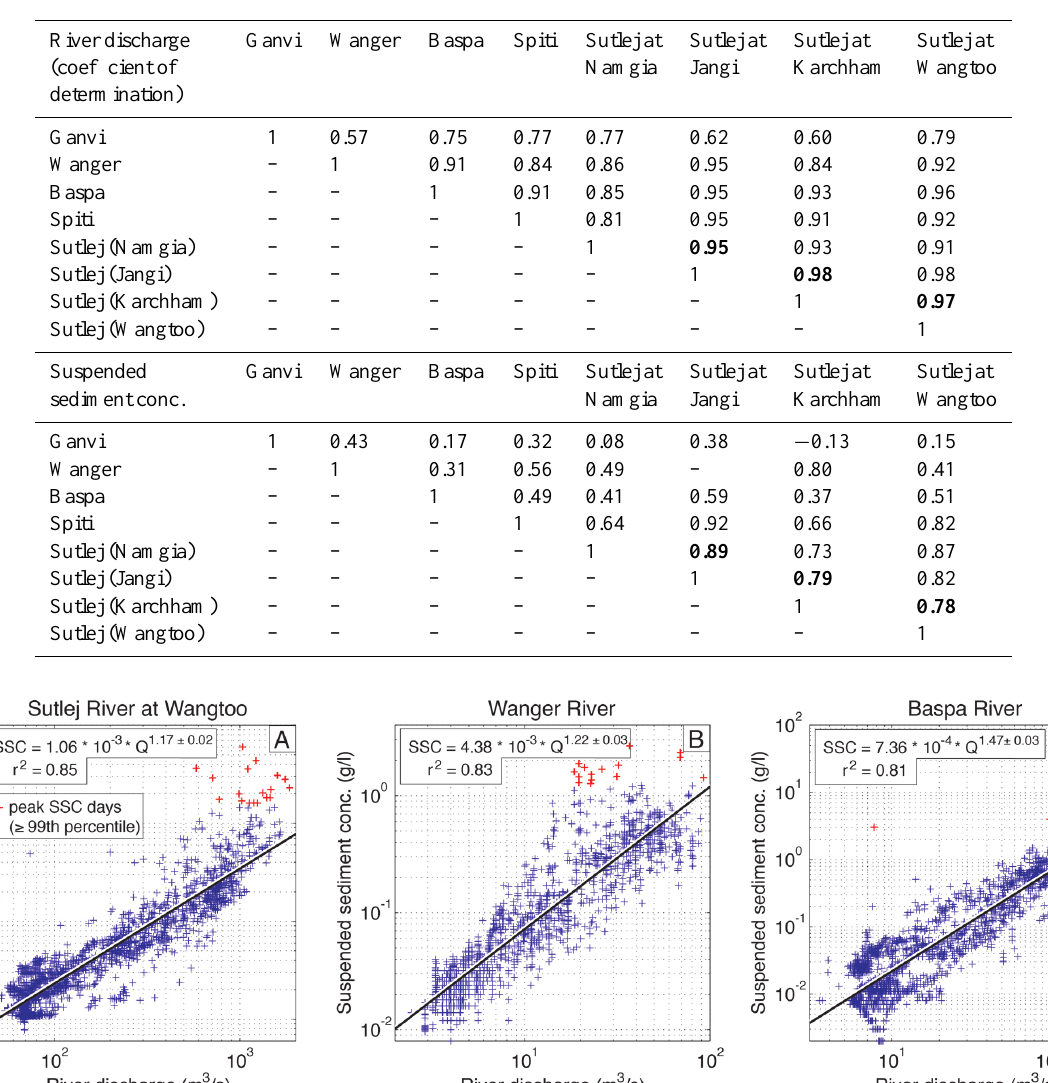
Table 3. Correlation of daily river discharge (top) and daily suspended sediment concentration (bottom) among different gauging sites. Neighboring stations along the Sutlej, which are expected to correlate strongly, are marked bold.